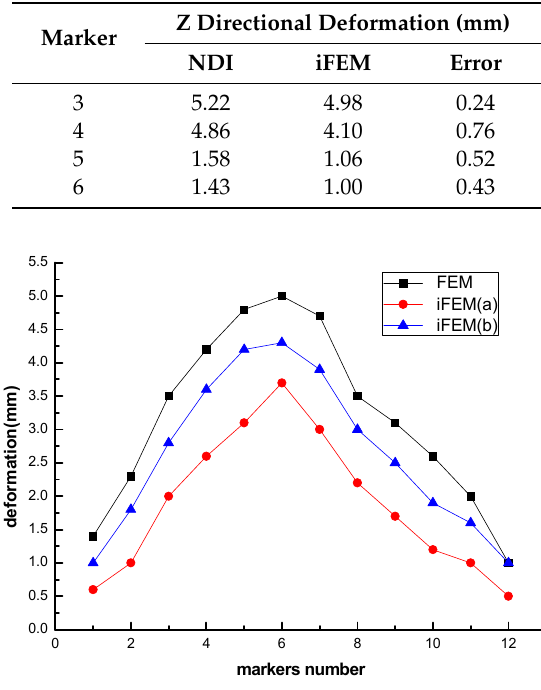
Figure 7. Deformation of plate structure.